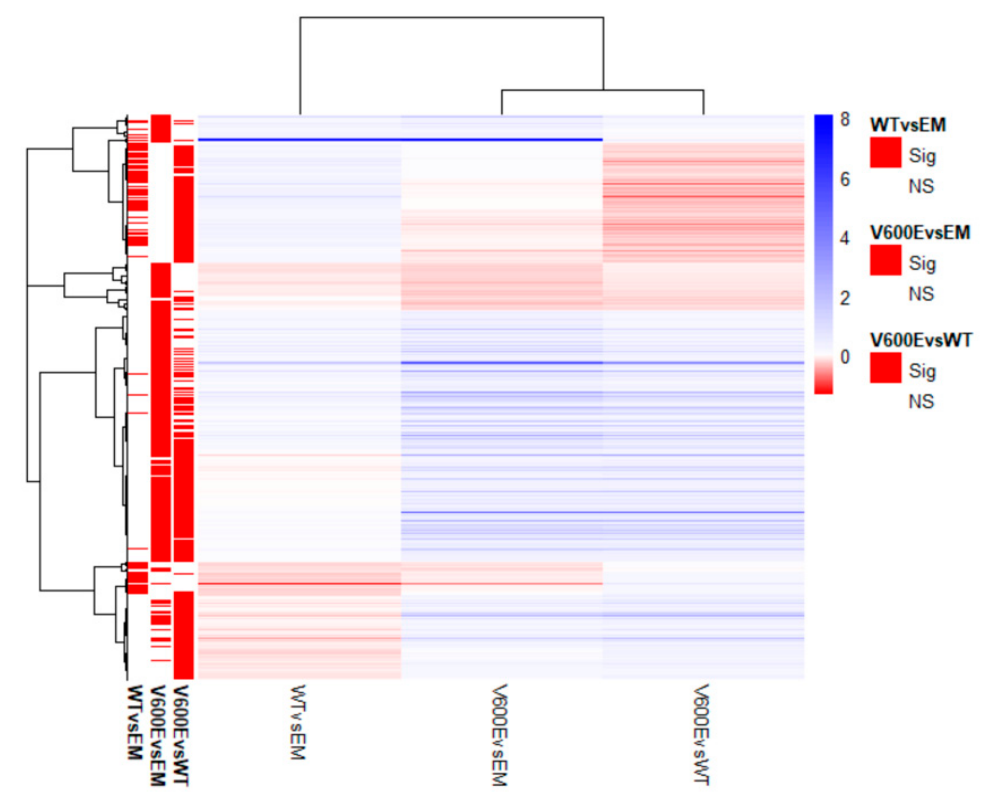
Figure 7. Heatmap of all significantly differentially expressed genes. Rows represent genes and each column is a contrast. The bars on the left display significantly expressed genes. In the main plot, the scale runs from red (negative fold change) to blue (positive fold change). The blue bar near the top of the plot is BRAF and BRAFP1 (BRAF Pseudogene 1), where the fold change is highest compared with the empty plasmid-transfected cells. Table 2. The 25 most strongly up-regulated and down-regulated genes in THLE-2 cells. Results are presented as a fold change (log ratio) in BRAF V600E versus BRAF WT comparisons. Up-Regulated